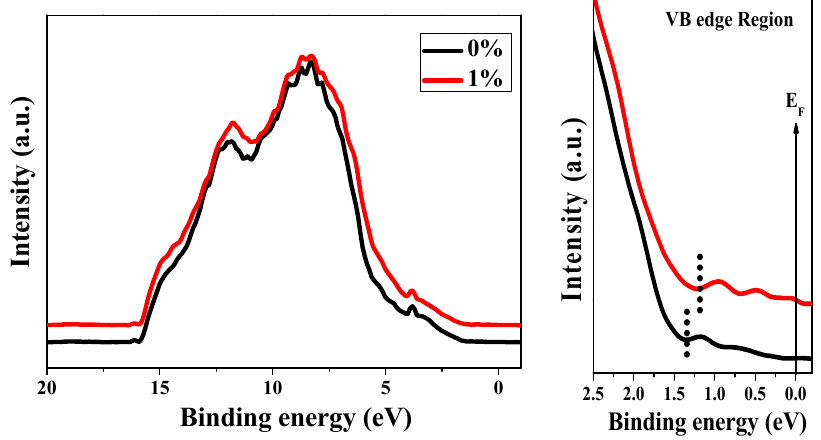
Figure 4. The UPS spectra of pristine MAPbI 3 film and 1.0% Ag-doped perovskite film.